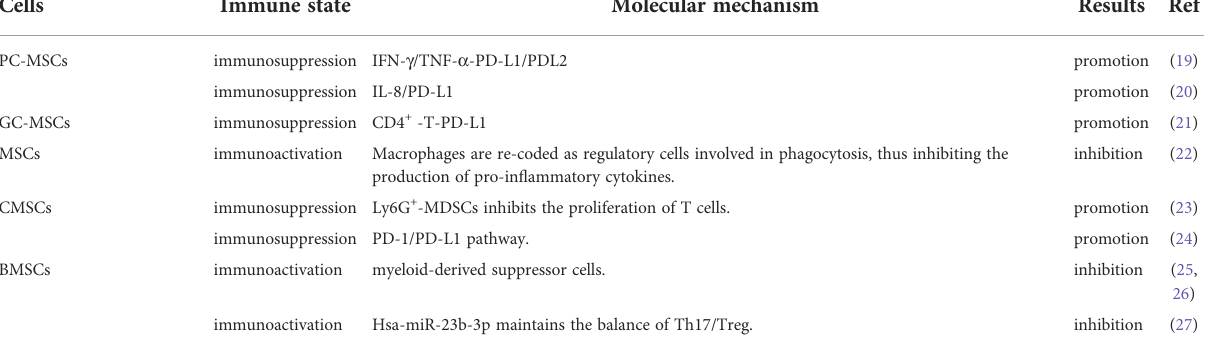
TABLE 1 The cancer immunomodulatory effects of various